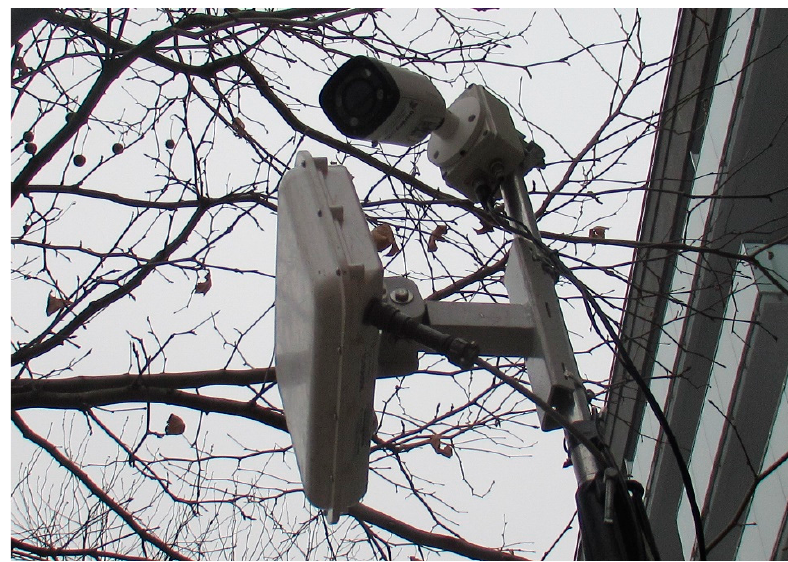
Figure 2. Perpendicular radar and CCTV IP camera (own